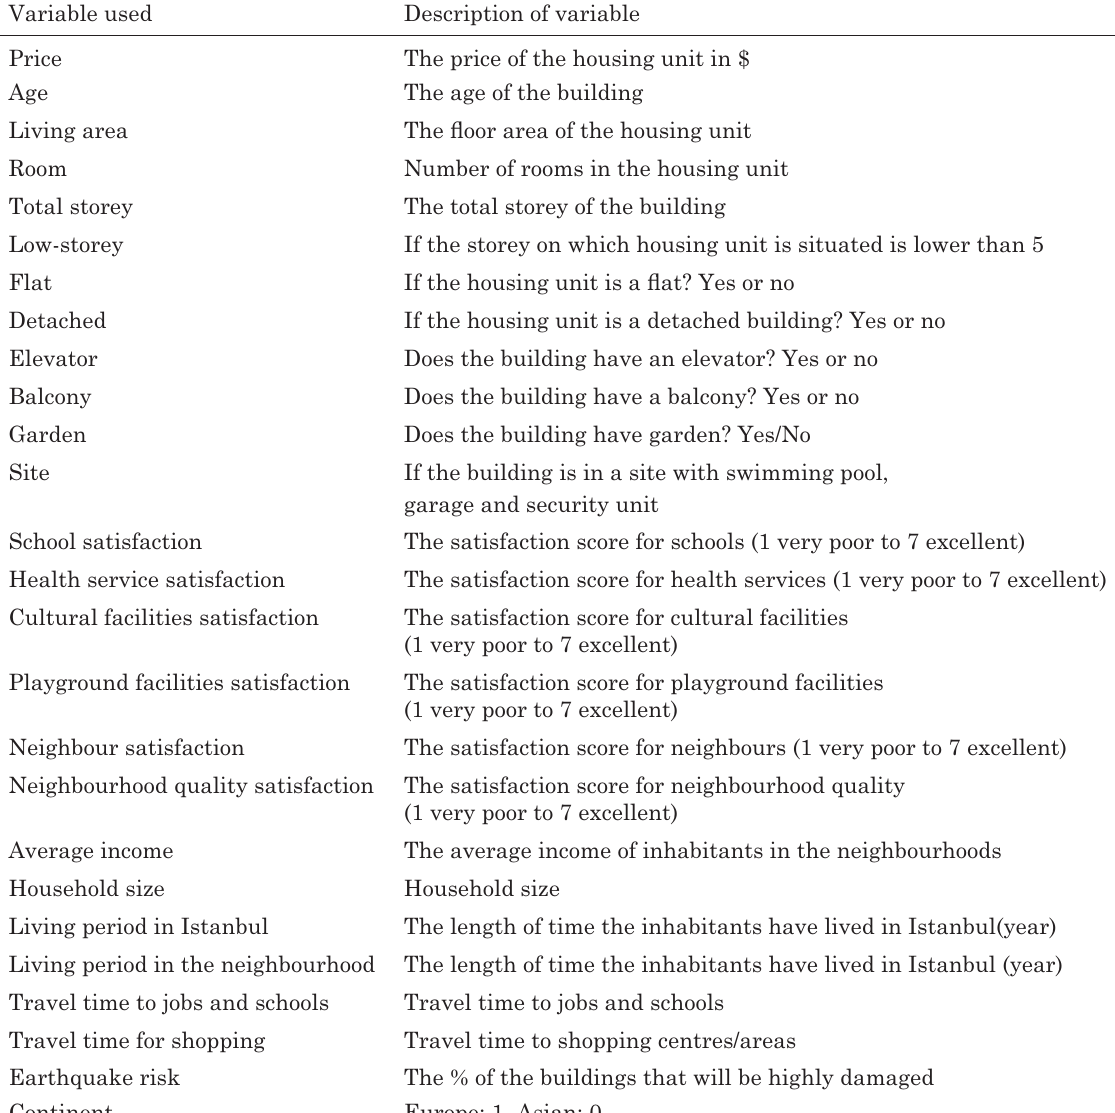
Table 3. Variables and description of variables Variable